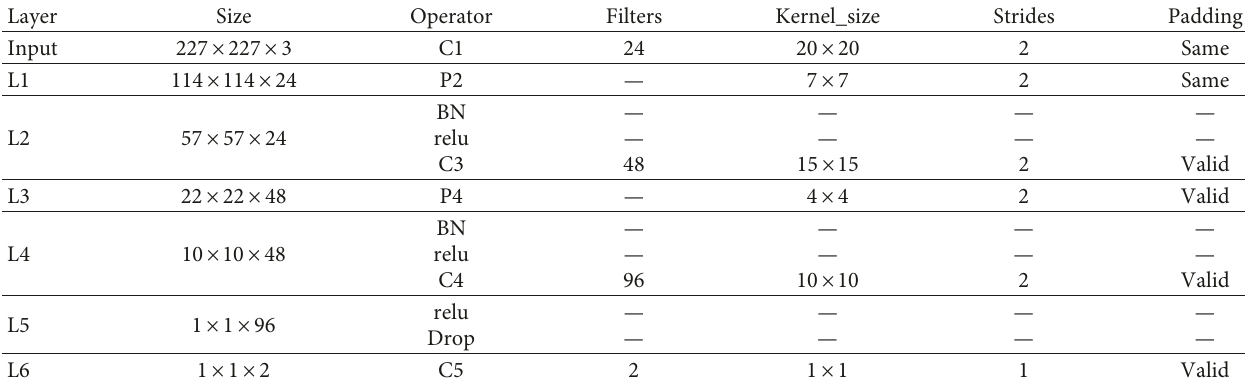
Table 1: Network